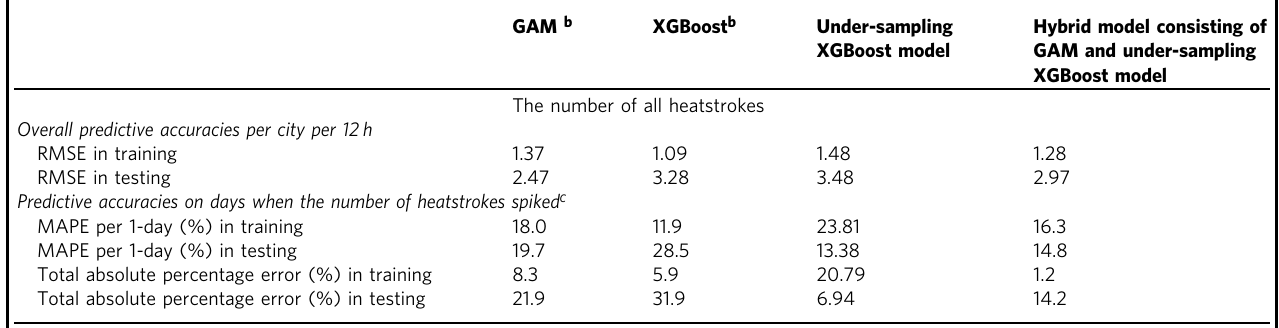
Table 3 Prediction performances of prediction models related to under-sampling and bagging techniques for the number of all heatstrokes a .